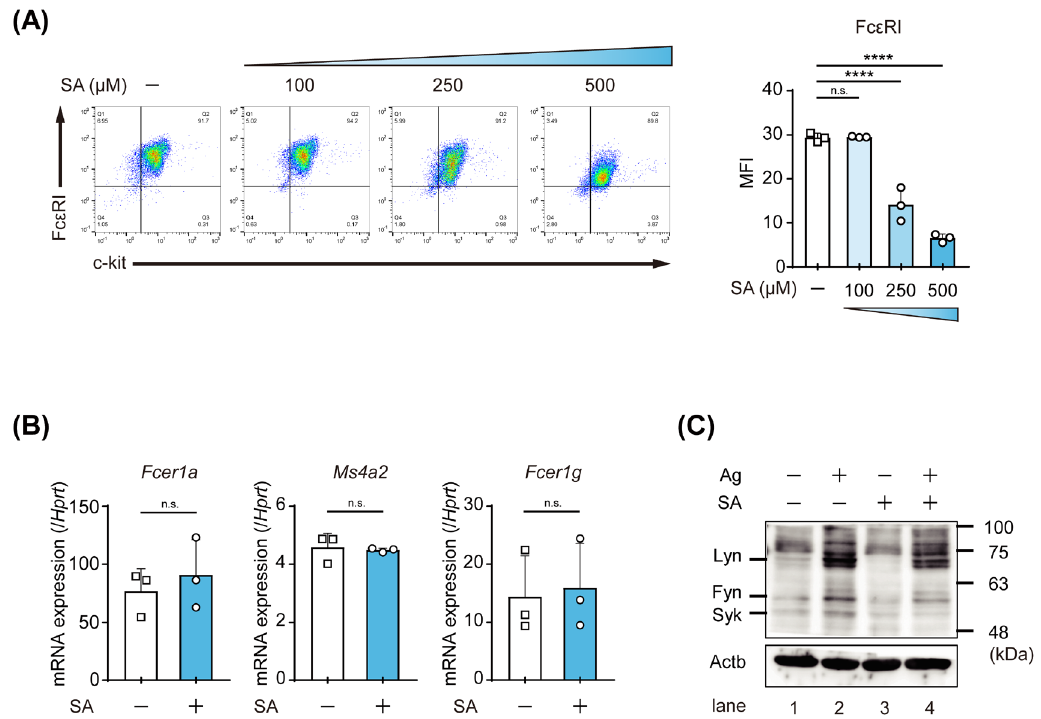
Figure 3. Salicylaldehyde reduced cell surface expression levels of Fc ε RI on MCs and IgE-mediated signal transduction in MCs. ( A ) Cell surface expression levels of Fc ε RI and c-kit. Typical dot plot profiles (left) and the mean fluorescence intensity (MFI) of Fc ε RI obtained in 3 independent experiments. BMMCs incubated in the presence or absence of the indicated concentrations of salicylaldehyde (SA) for 48 h were stained with anti-Fc ε RI Ab and anti-c-kit Ab. ( B ) mRNA expression levels of Fc ε RI α ( Fcer1a ), β ( Ms4a2 ), and γ ( Fcer1g ) subunits. BMMCs pretreated with 500 μM salicylaldehyde (SA+) or its control (SA − ) were harvested to assess mRNA levels by qPCR. ( C ) Western blot analysis of tyrosine-phosphorylated proteins. BMMCs treated with 500 μM salicylaldehyde for 48 h (SA+) and its control (SA − ) were stimulated with IgE plus TNP-BSA (Ag) for 10 min. The expected molecular weights of Lyn, Fyn, and Syk were marked on the left. A typical result is shown, and similar results were obtained in 2 other independent experiments. Data shown in ( A (right) and B ) represent the mean ± SD of 3 independent experiments. Tukey’s multiple comparison test ( A right) and the t -test ( B ) were used for statistical analyses. n.s., not significant; ****, p < 0.0001.